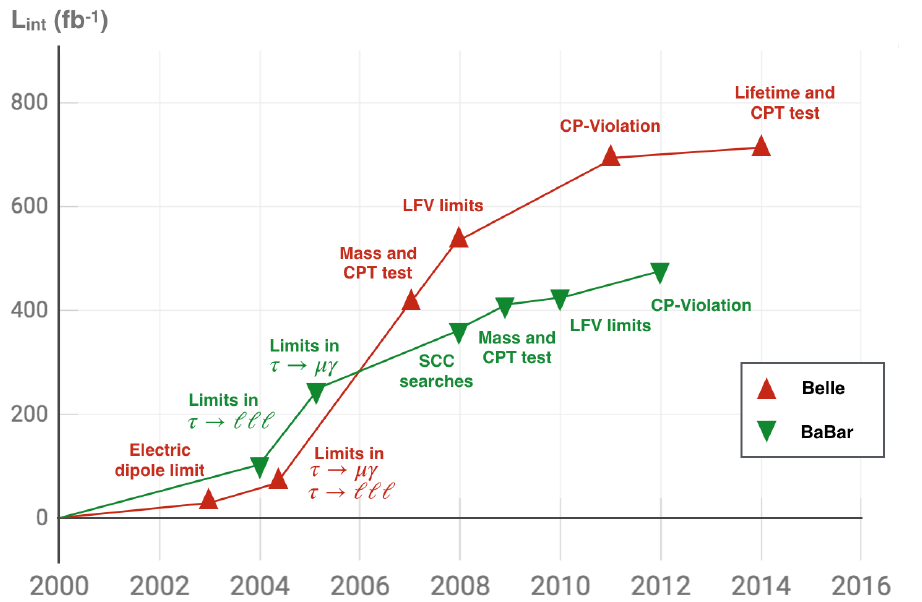
Figure 1: Highlights of the τ lepton physics results in the first generation of B- factories, indicating the integrated luminosity accumulated and the year of the mea-